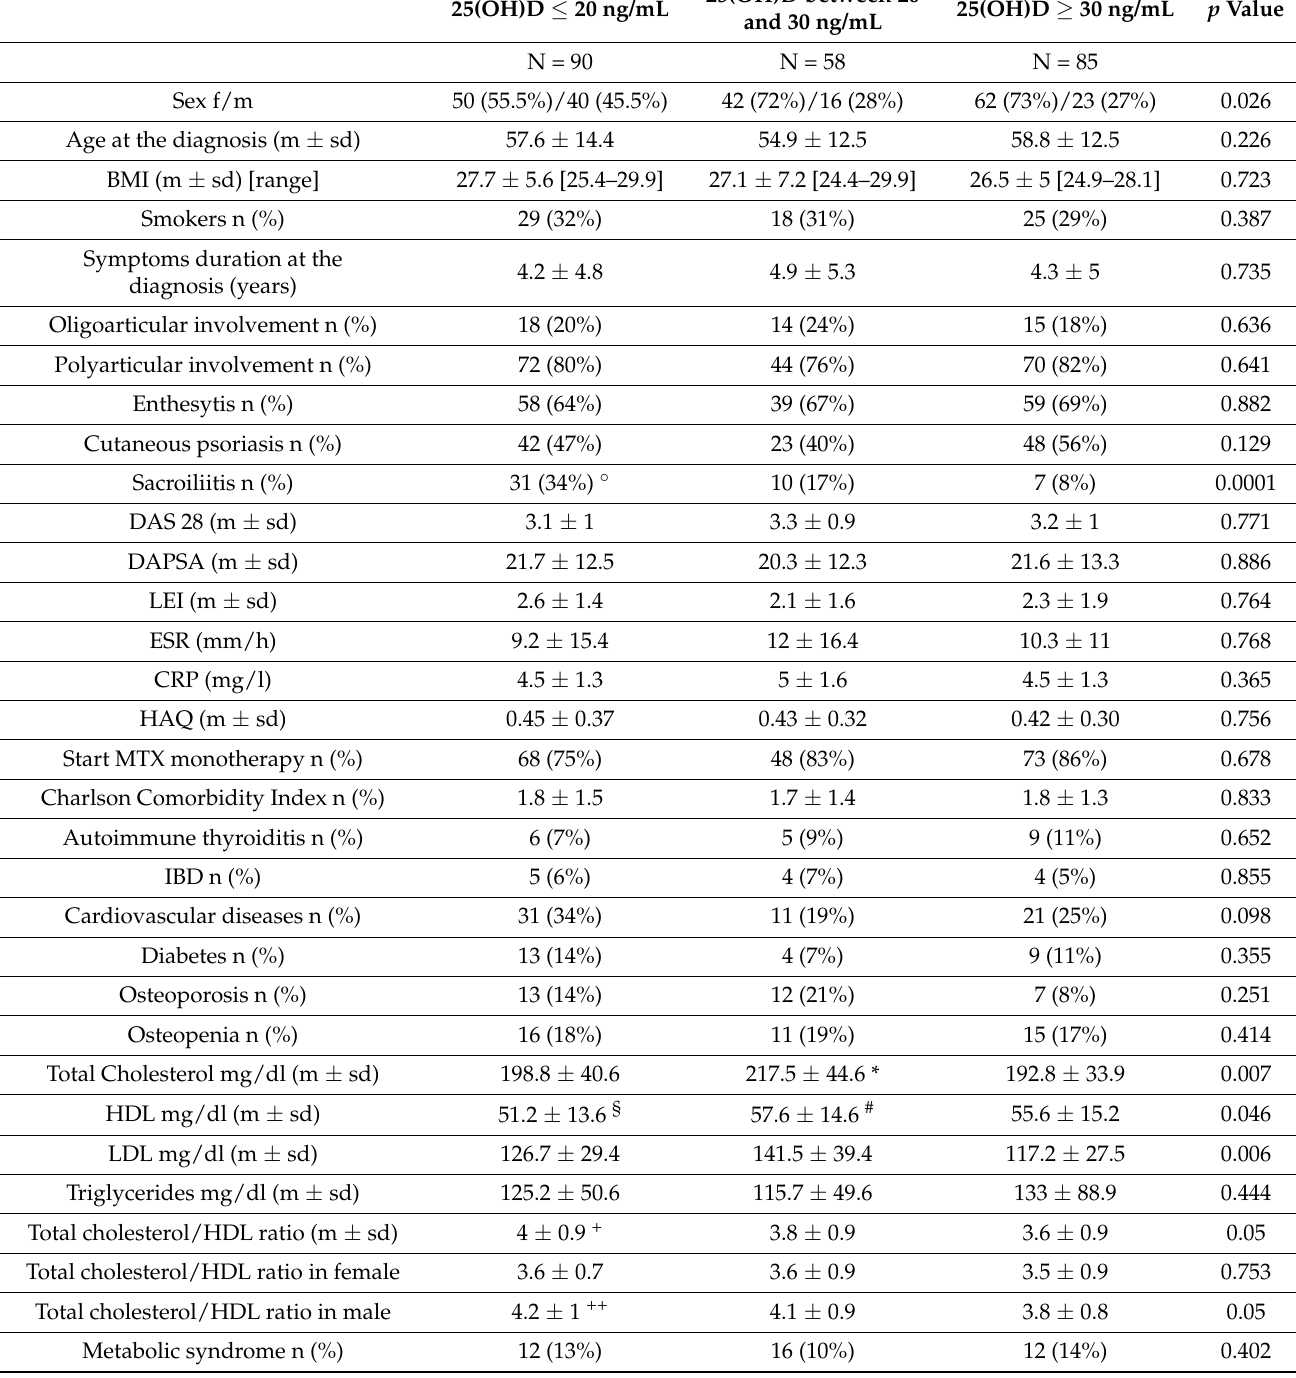
Table 1. Comparison of demographic and clinical features at the diagnosis of PsA time between patients with different statuses of 25(OH)D serum level: 25(OH)D ≤ 20 ng/mL vs. 25(OH)D